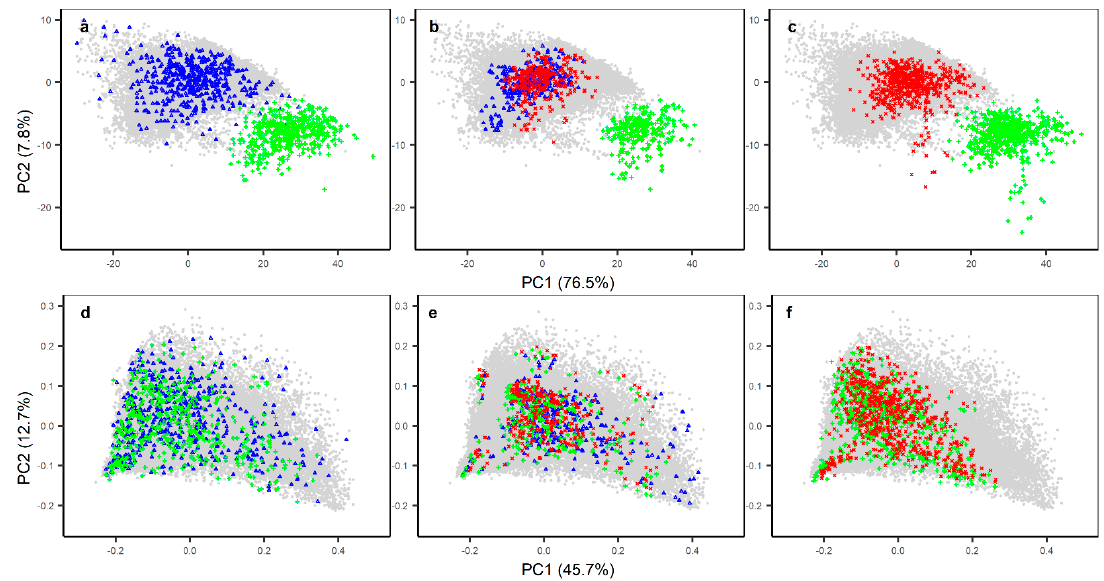
Figure 1. Relative locations of the transfer set ( a , d ) and two independent validation sets ( b , c , e , f ) in principal component space compared to the USDA National Soil Survey Center–Kellogg Soil Survey Laboratory (NSSC-KSSL) mid-infrared (MIR) library (grey dots) using the raw (top panel) and first derivative (bottom panel) spectra. The blue triangles are samples scanned using the primary KSSL spectrometer. The green plus signs are the samples scanned on the secondary Woodwell spectrometer and the red crosses are the Woodwell spectra after application of a piecewise direct standardization (PDS) transfer matrix built on the raw spectra using the transfer set.